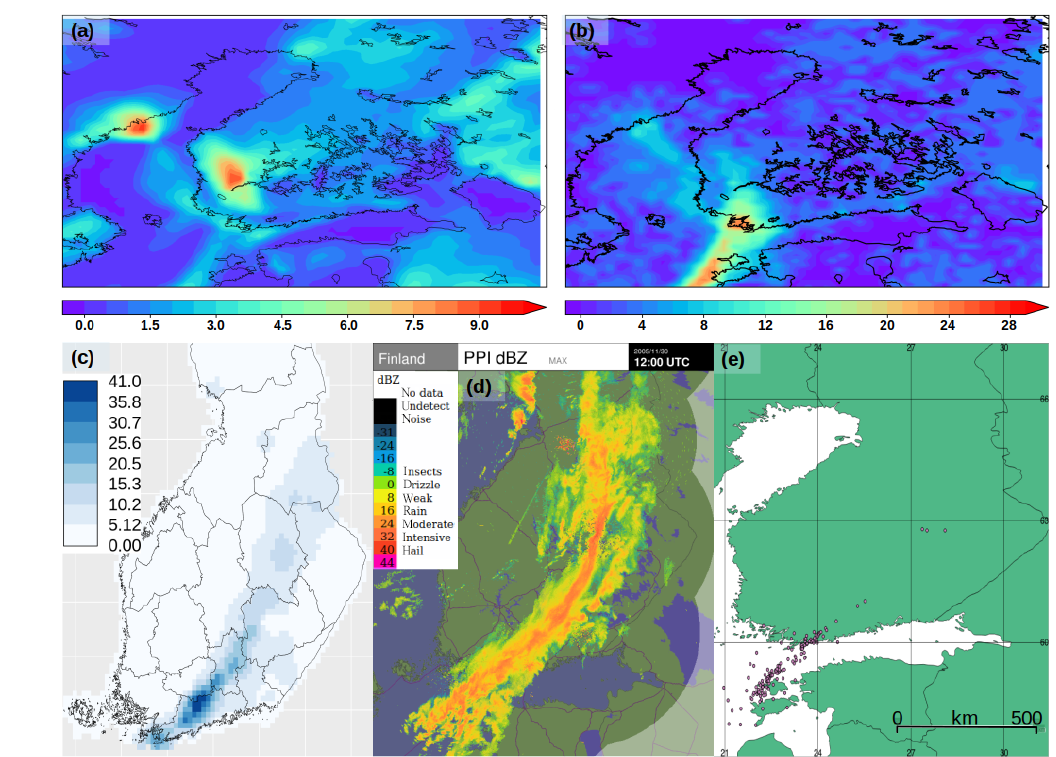
Figure A4. Precipitation in 30 November 2005 from different databases. (a) Accumulated snowfall from RCA4 (mmd − 1 ), (b) total precip- itation from RCA4 (mmd − 1 ), (c) total precipitation from FMIClimGrid (mmd − 1 ), (d) radar reflectivity factor (dBZ) image at 12:00UTC. (e) Located lightning strokes on 30 November 2005. In the map, a total of 160